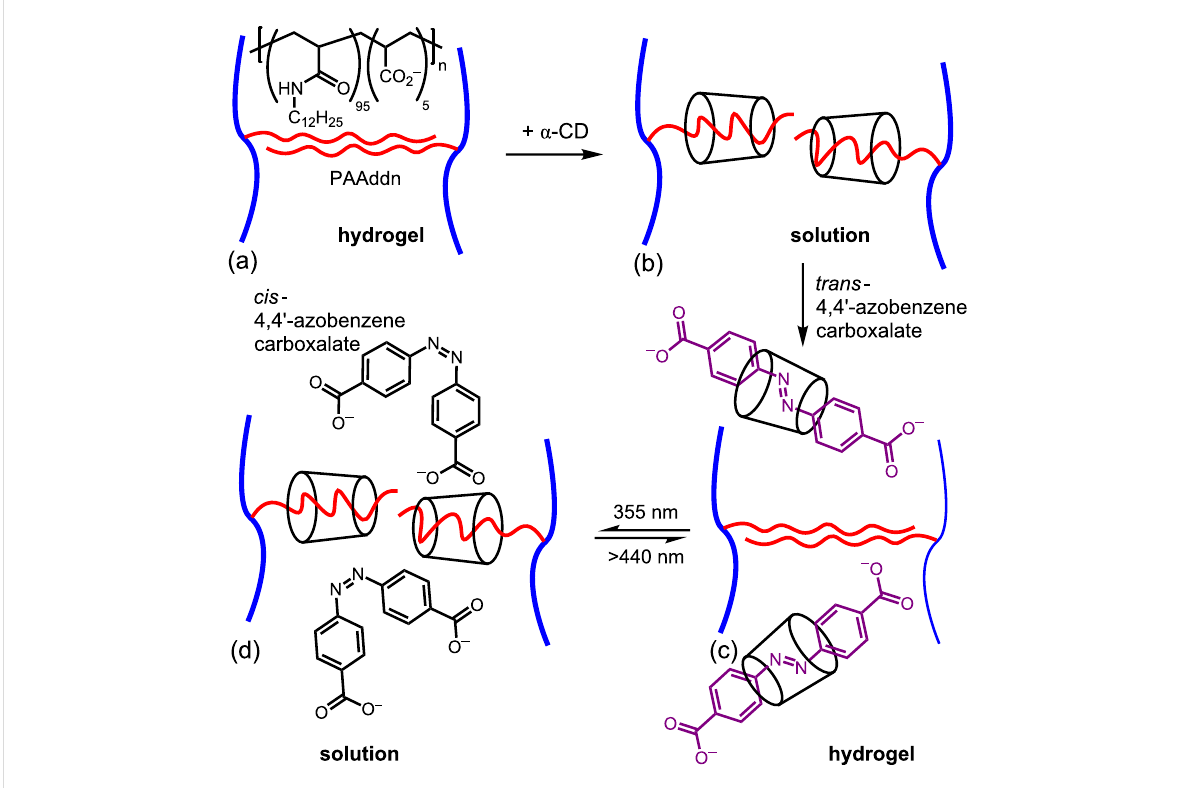
Figure 13: Solution to hydrogel transitions (a)–(d) for a PAAddn segment in the presence of competitive photo-responsive complexation of the dodecyl substituent by α -CD and E - or trans -4,4’-azobenzene carboxylate and its Z - or cis -isomer in basic aqueous solution